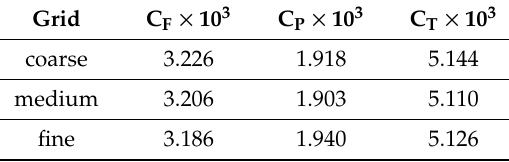
Table 7. Calculated resistance coe ffi cients at model scale (Fr = 0.18, Re = 7.68 × 10 6 ).